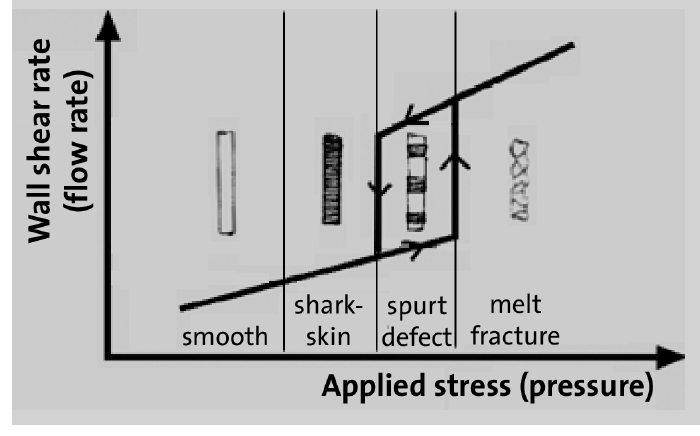
Figure 1: Typical flow curve of polymer melts and general extrudate